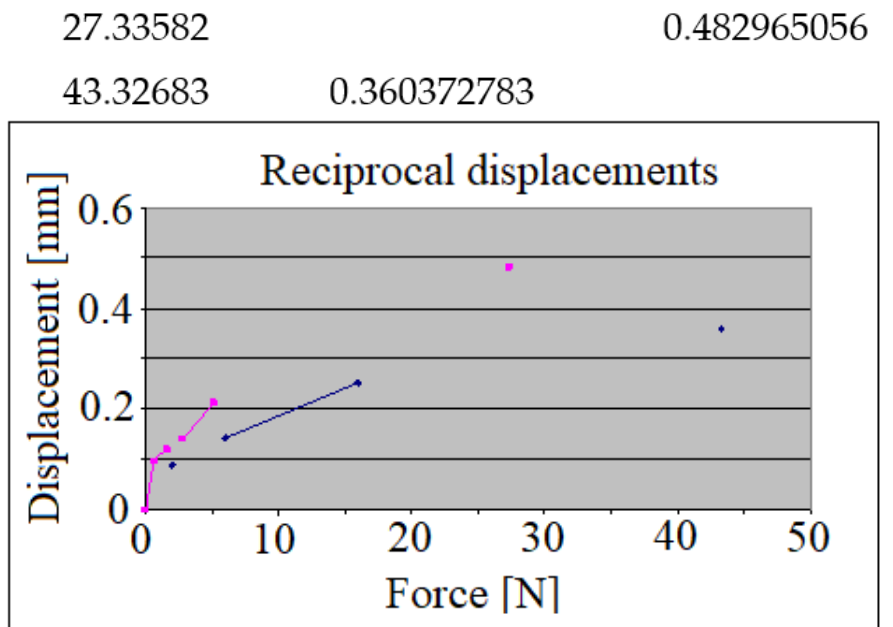
Figure 13. The reciprocal displacements of the crowns during the mastication: the implant’s displacement during the natural tooth’s loading (blue), as well as the natural tooth’s displacement during the implant’s loading (red).